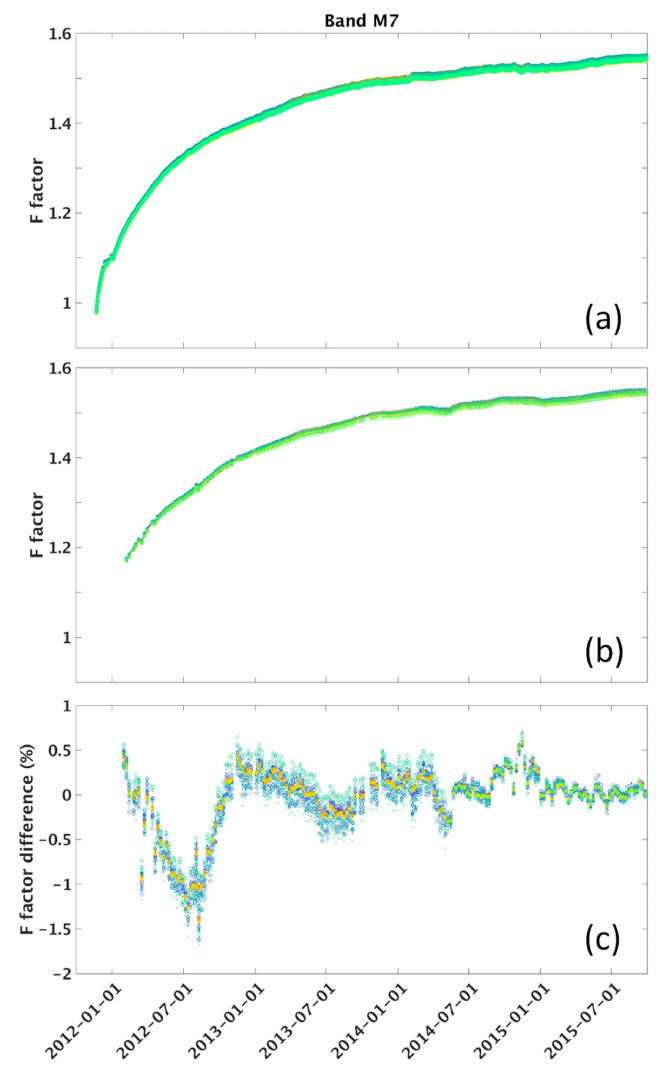
Figure 5. ( a ) VIIRS band M7 (865 nm, dual gain) radiometric calibration scaling coefficients (the F factors) derived by the automated calibration procedure; ( b ) the F factors used in the operational production of the VIIRS SDR; and ( c ) relative difference between the operational F factors and the reprocessed ones (used here as a baseline). Symbol legend is the same as in Figure